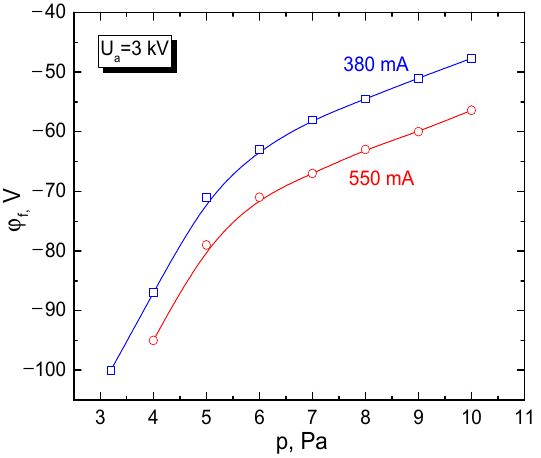
Figure 19. Dependence of the potential of insulated target on pressure. Working gas: helium. Electron-beam parameters: ( Blue )—380 mA, 3 keV; ( Red )—550 mA, 3 keV [129]. The potential is negative due to accumulation of negative charges on the surface.